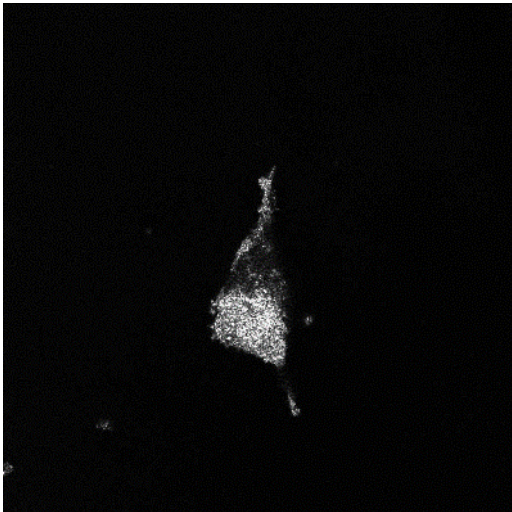
Figure 9. Confocal image of an HeLa cell in the reflection mode.